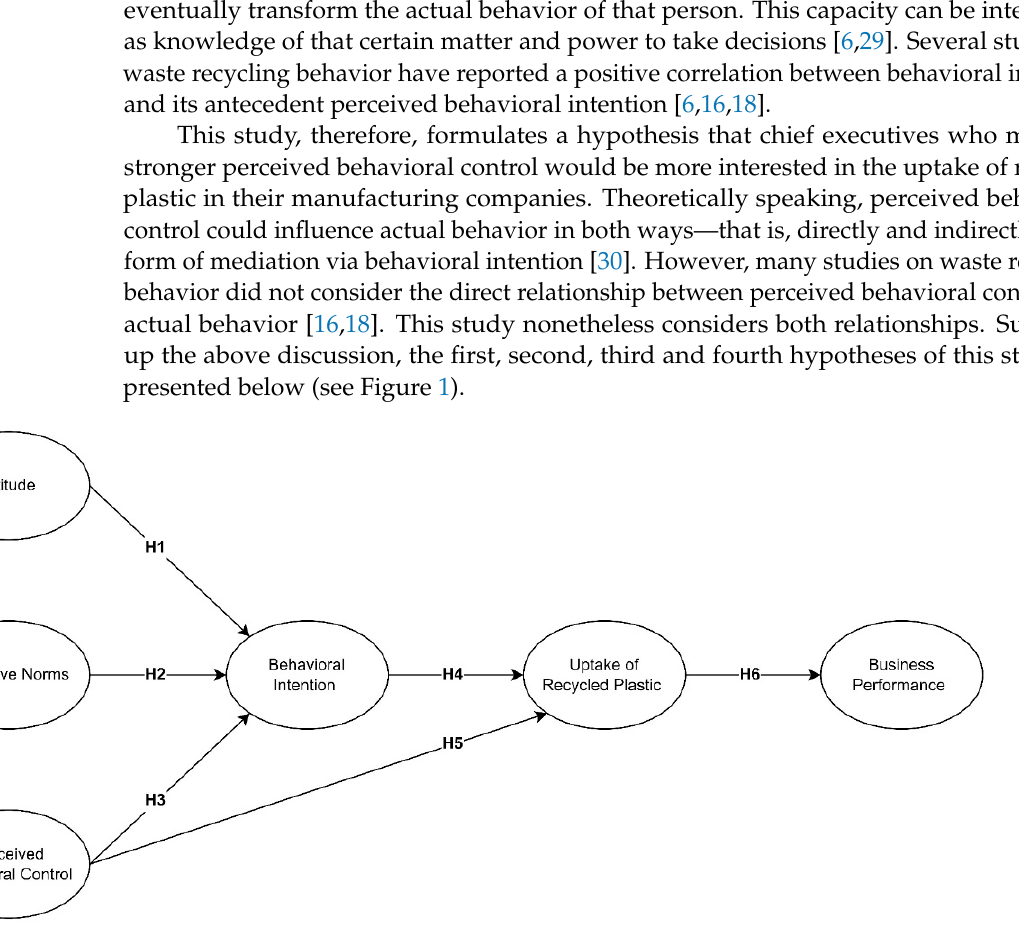
Figure 1. Research model (hypotheses).